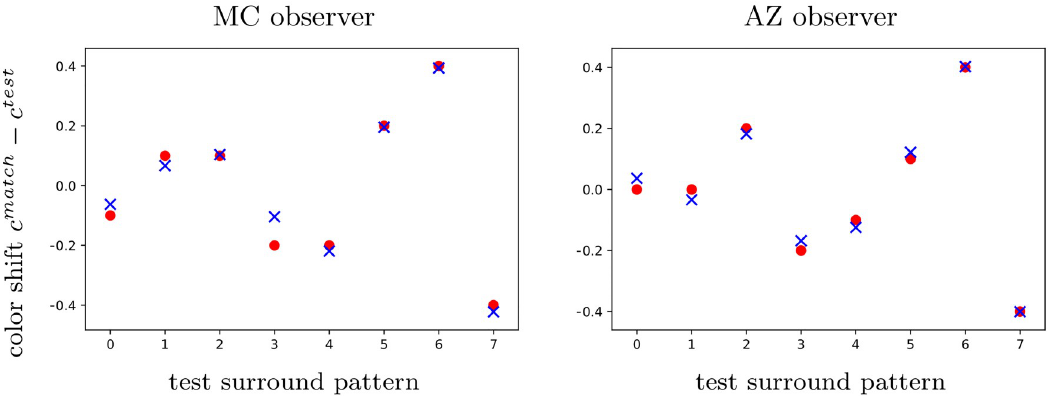
Fig 9. Our tuned model predicts color shifts from [18]. Left. Observer ‘MC’. Right. Observer ‘AZ’. Red dots indicate experimental data, while blue crosses stand for predicted matching comparison colors. The data has been averaged over three sets of experiments, as detailed in the original article. The ordinate corresponds to the color shift, expressed in C abscissa i = 0, ... , 7 refers to the test pattern: p/p, l/l, p/w, l/w, w/p, w/l, p/l, l/p, where p stands for purple, l for lime, w for white.